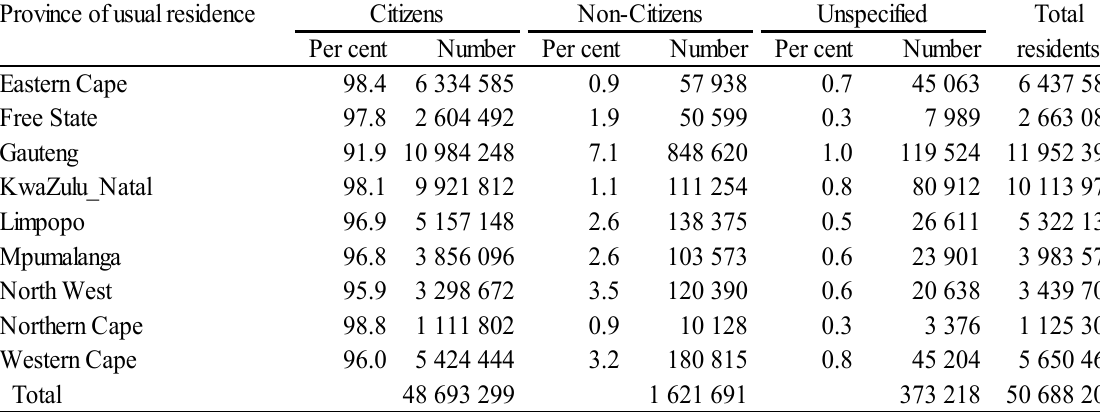
Table 1: Number of usual residents by citizenship according to province, 2011 Population